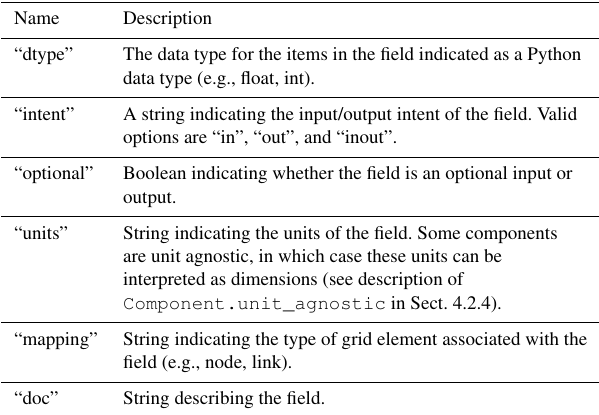
Table 7. Metadata for fields component